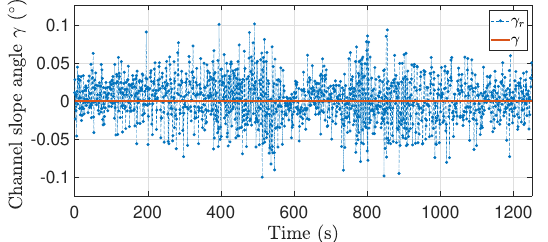
Figure 11: (a) Radar level measurements for a non- Newtonian fluid and (b) the ultrasonic level measurements for a Newtonian fluid (wa-